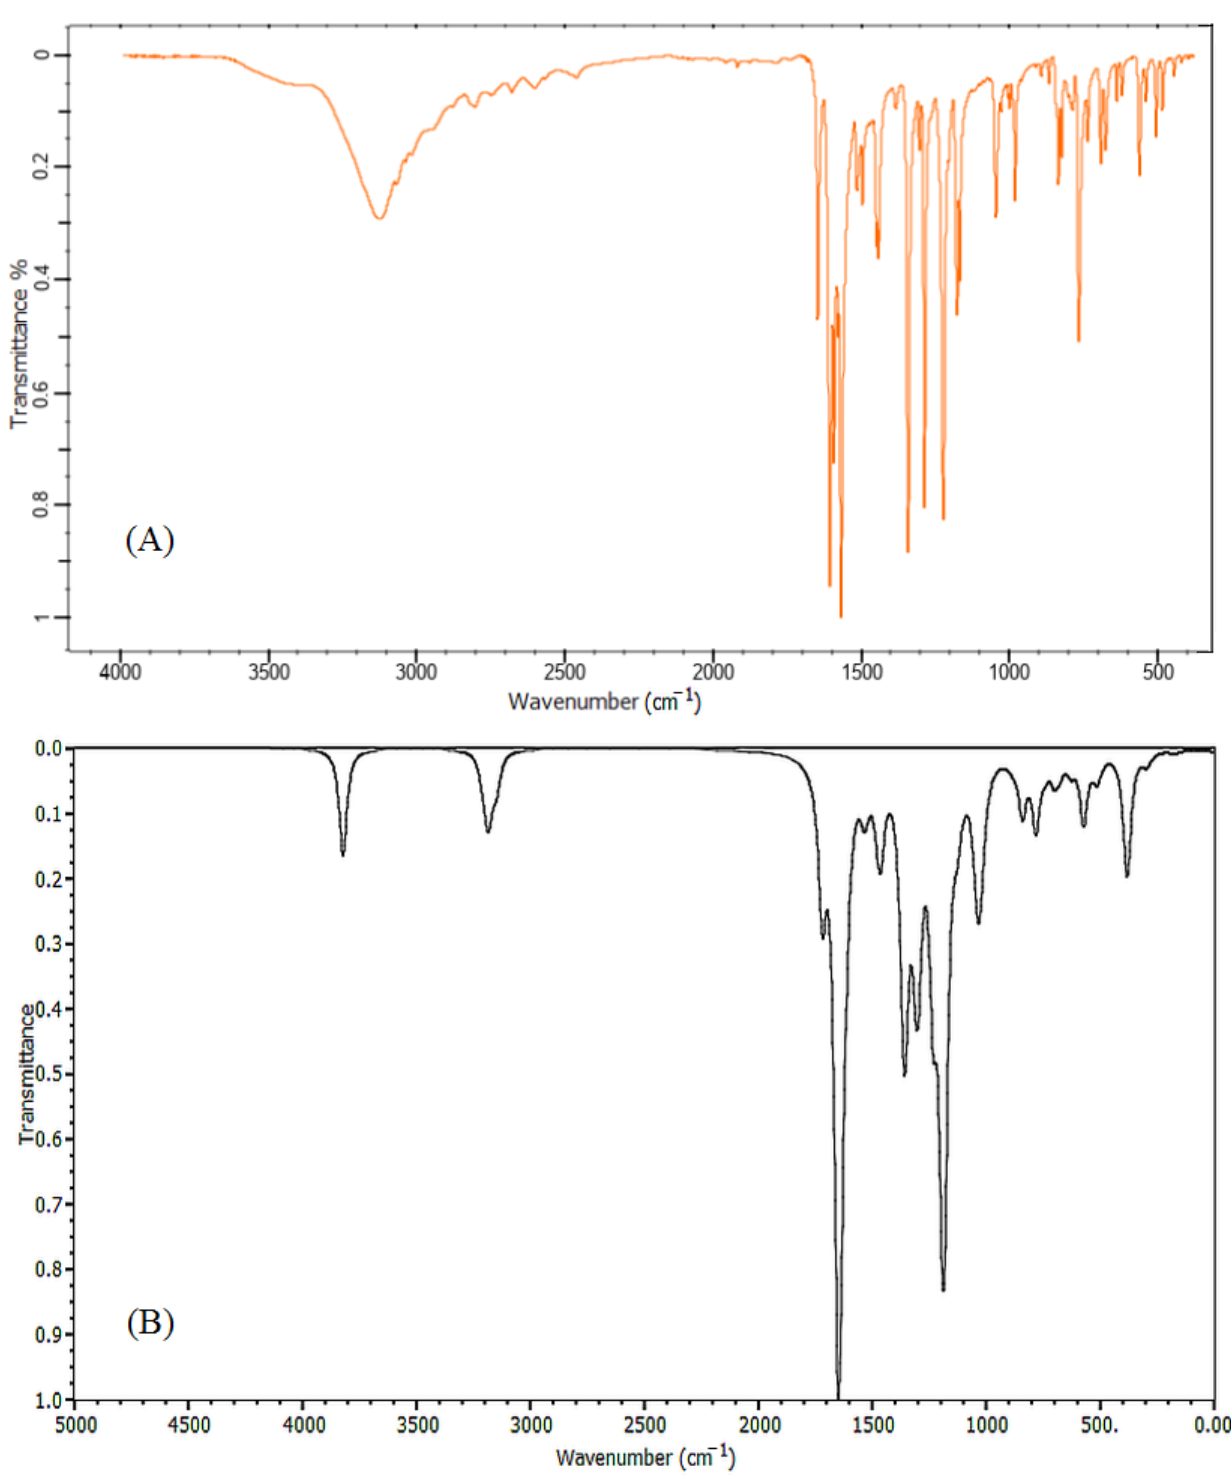
Figure 2. Experimental ( A ) and simulated ( B ) FT-IR spectra of 1-(4-Hydroxyphenyl)-3-phenylprop-2-en-1-one.